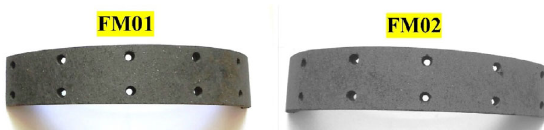
Fig. 2 Developed friction composites (FM01 and